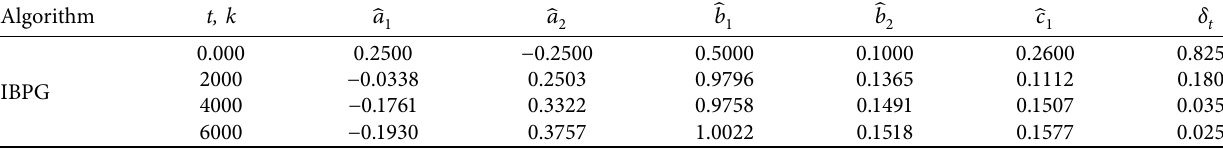
Table 1: The vector parameter estimates 􏽢 θ t and their parametric errors δ t for the FSOEAHW model using IBPG algorithm.